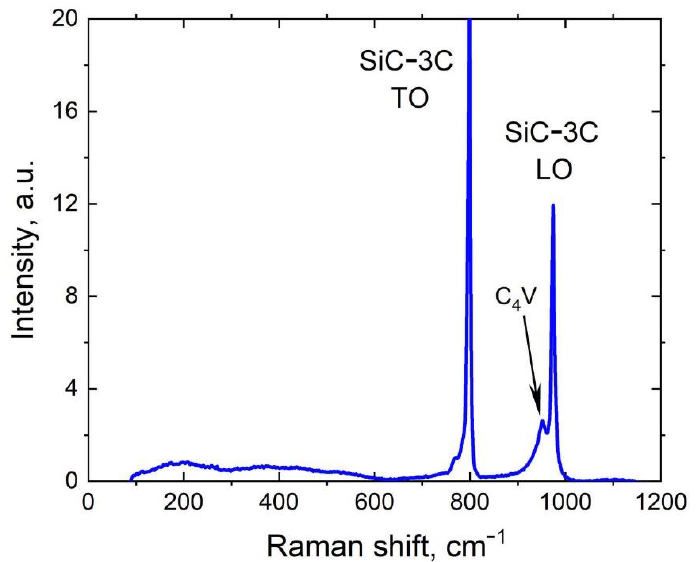
Figure 6. RS of the 3C-SiC/Si(111) sample produced at t a = 25 min. There is an additional peak at 952 cm − 1 , corresponding to silicon vacancies in a stable state (C 4